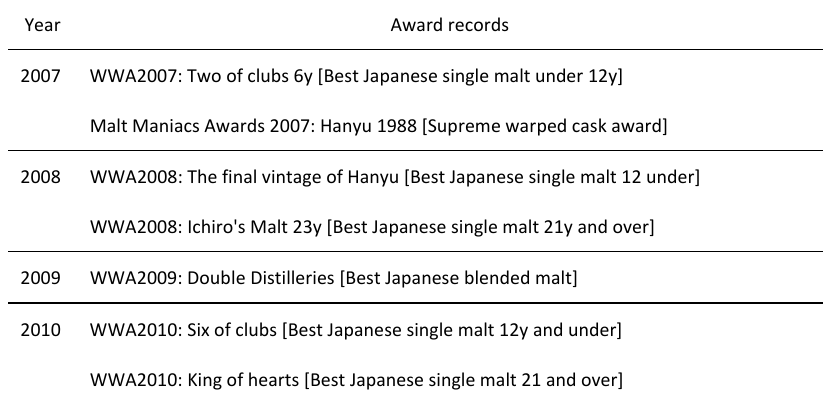
Table 1. Award records of Venture Whisky Year Award records